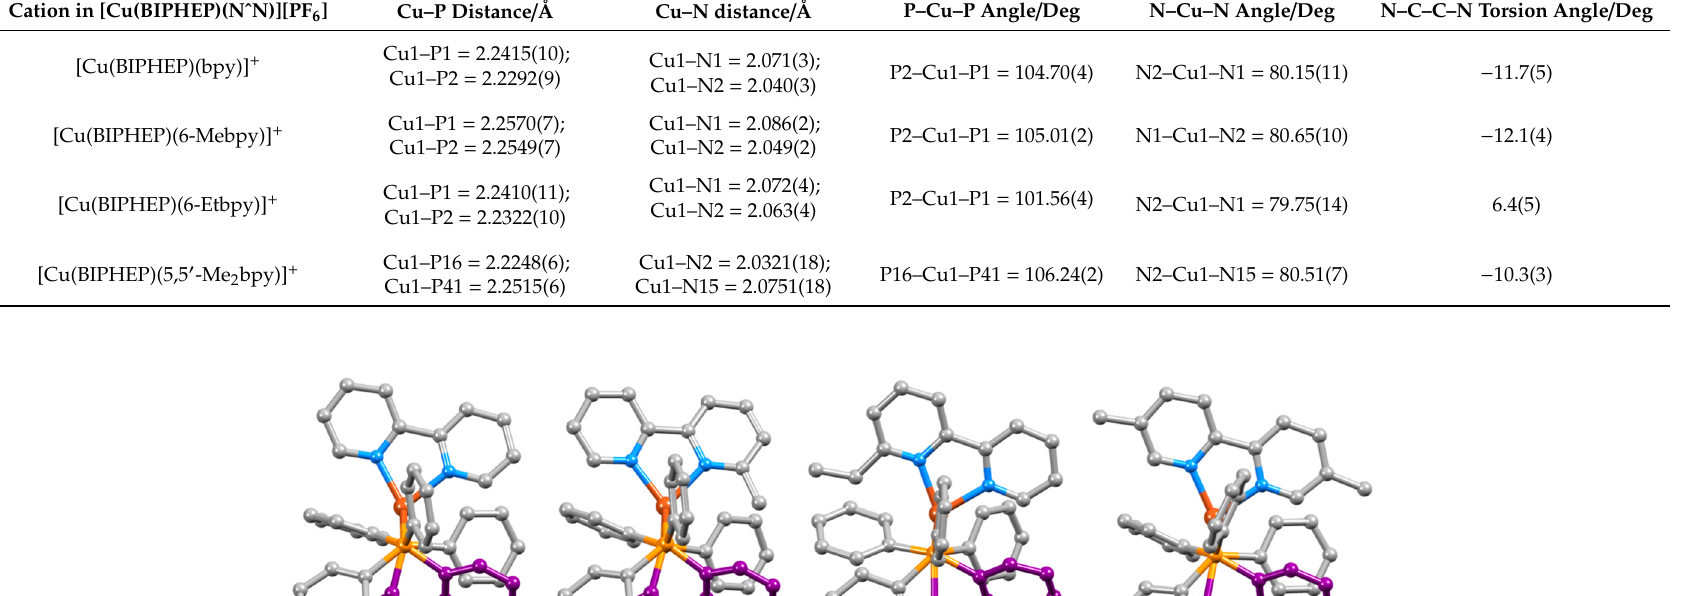
Table 1. Selected structural parameters for the [Cu(BIPHEP)(N^N][PF 6 ] compounds.